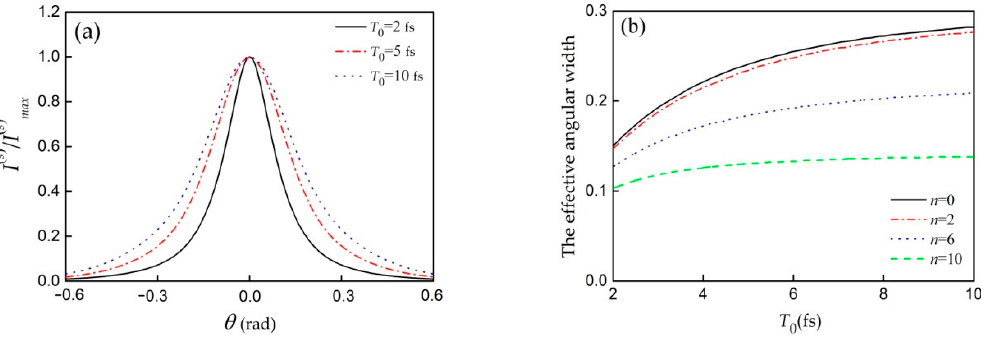
Figure 3. ( a ) Normalized intensity of scattered pulse against scattering angle θ for different initial pulse duration T 0 . ( b ) Effective angular width of scattered pulse against initial pulse duration T 0 .